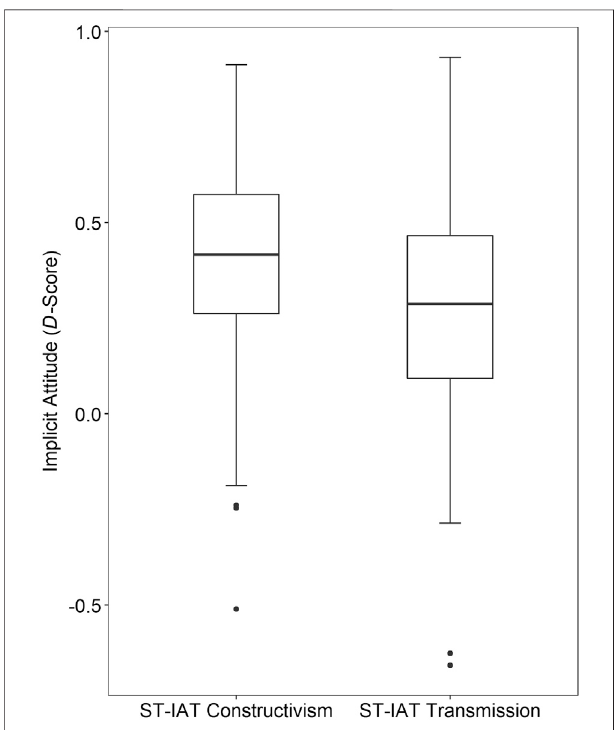
FIGURE 2 | Implicit constructivist and transmissive attitudes of all participants at T 1 ( N (cid:1)